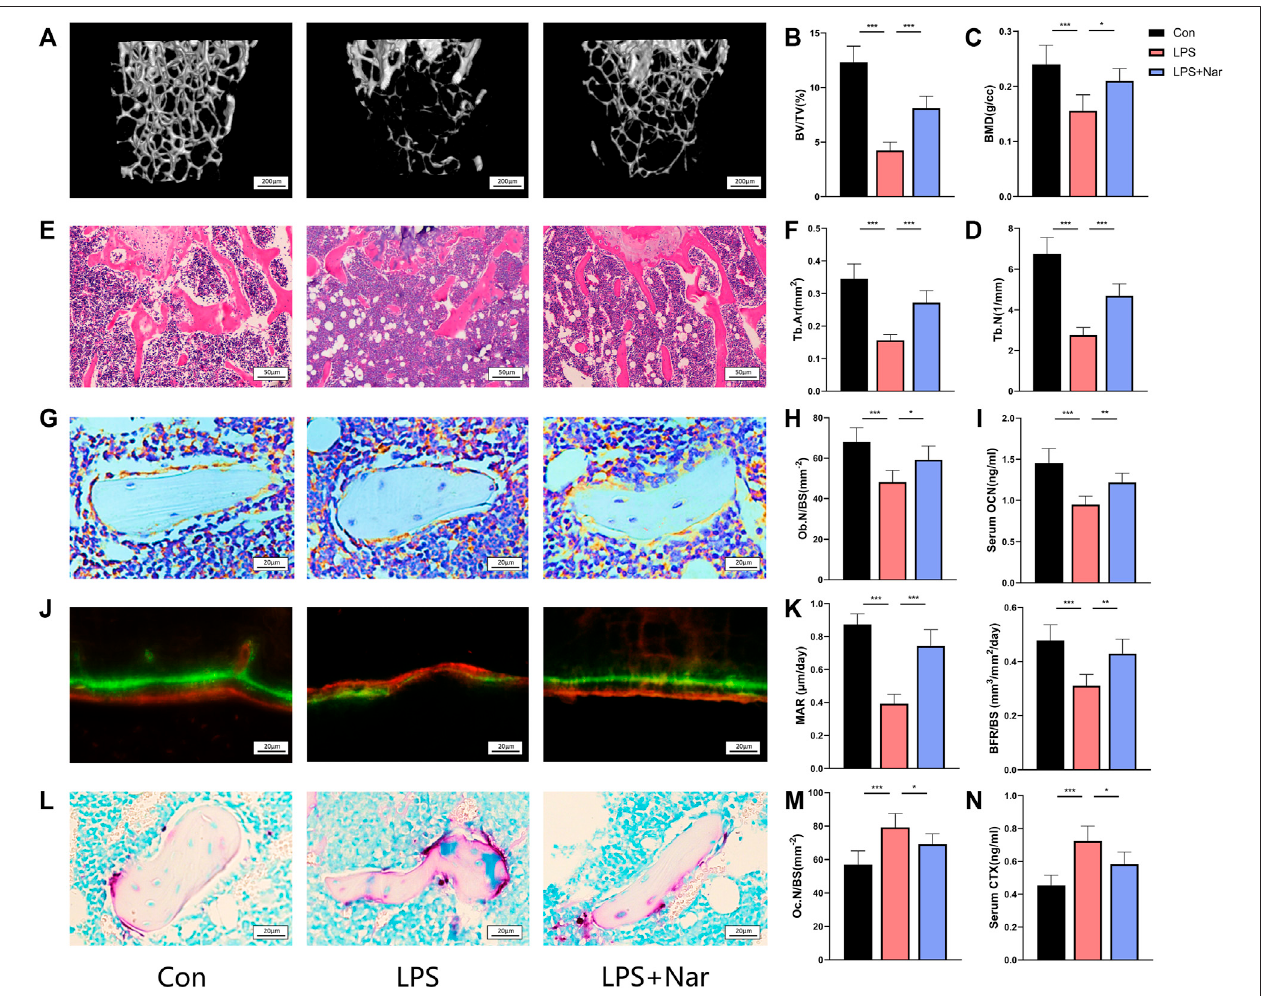
FIGURE 7 | Naringenin alleviates LPS-induced bone loss. (A) Representative μ CT analysis of trabecular bone of the distal femur. (B – D) Calculations of bone volume/total volume (BV/TV), trabecular bone mineral density (BMD), and trabecular number (Tb.N). (E) Representative H&E staining of distal femoral sections. (F) Quanti fi cation of trabecular area (Tb.Ar) from H&E staining. (G) Osteocalcin (OCN) stained sections of the distal femur. Original magni fi cation ×40. (H) Osteoblast (OCN positive) number per bone surface (Ob.N/BS). (I) Serum level of osteoblast marker OCN. (J) Representative calcein staining of trabecula of distal femoral sections. (K) Quanti fi cation analysis of calcein staining. Mineral apposition rate (MAR) and bone formation rate per unit of bone surface (BFR/BS). (L) Tartrate-resistant acid phosphatase (TRAP) stained sections of the distal femur. Scale bar: 20 μ m. (M) Osteoclast (nuclei > 3; TRAP positive) number per bone surface (Ob.N/BS). (N) Serum level of osteoclast marker CTX-I. n = 5 replicates per group in all panels. Data are expressed as mean ± SD. * p < 0.05; ** p < 0.01; *** p <